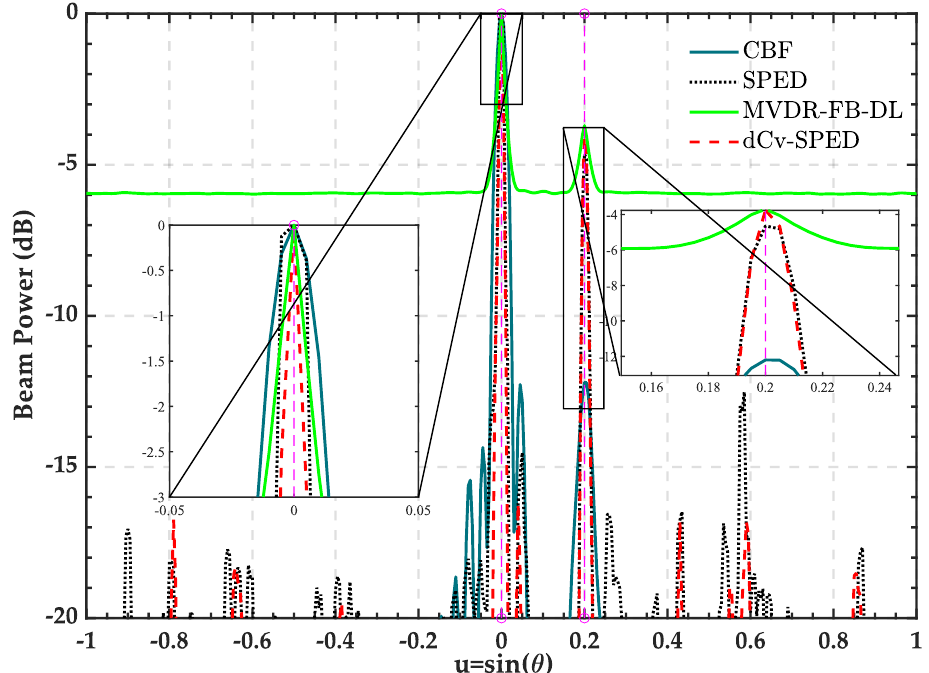
Figure 7. Spatial-spectra estimated by the CBF, SPED, MVDR-FB-DL, and dCv-SPED under array perturbations.